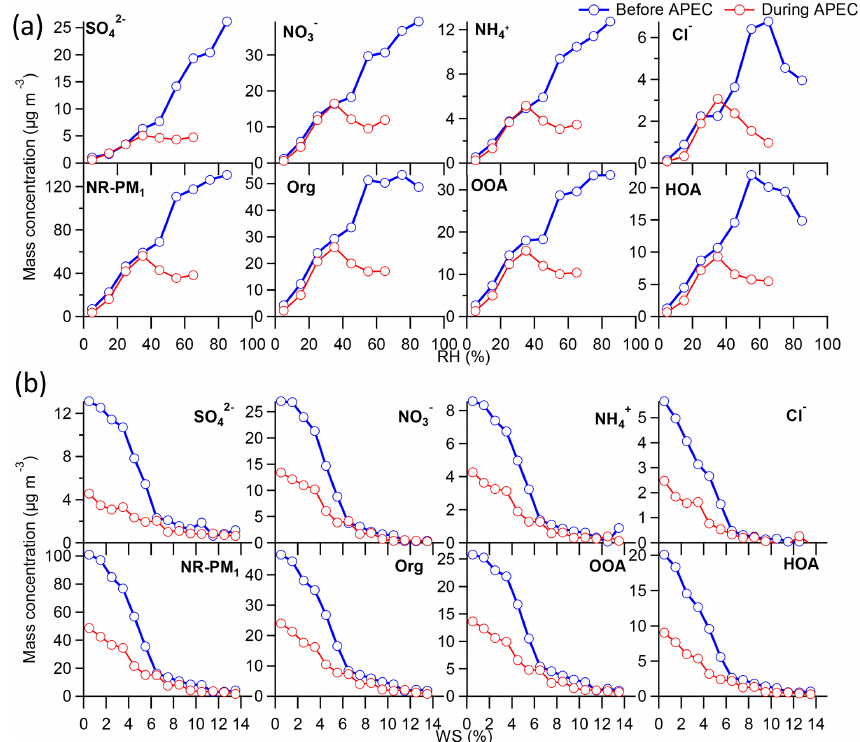
Figure 8. Variations of NR-PM 1 species and OA factors as a function of (a) RH and (b) WS before and during APEC. The RH and WS were from the tower measurements at